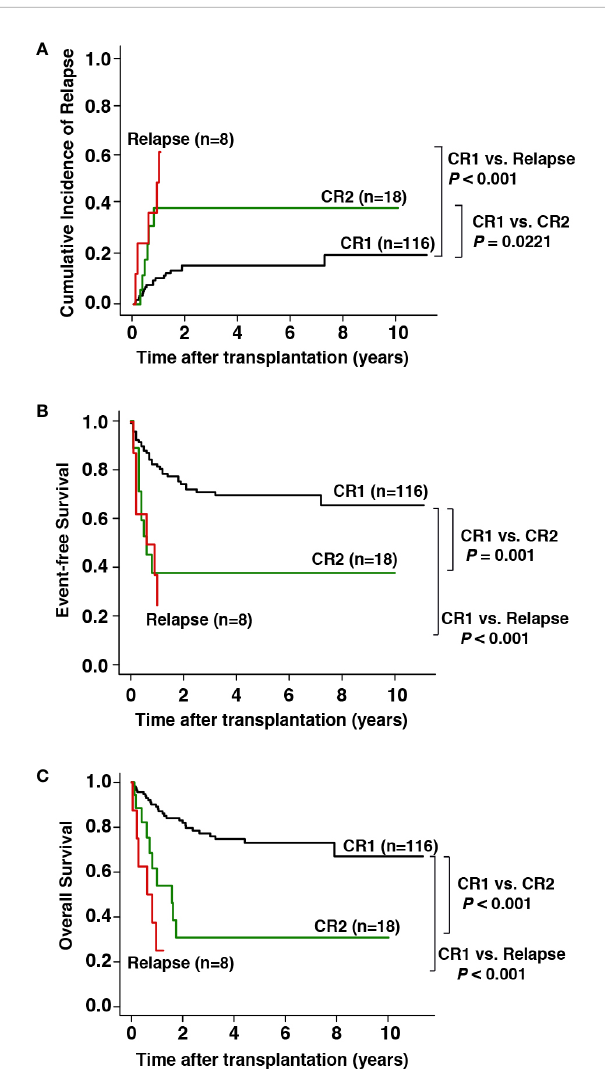
FIGURE 1 Prognostic impact of disease status at transplantation on outcomes. FIGURE 2